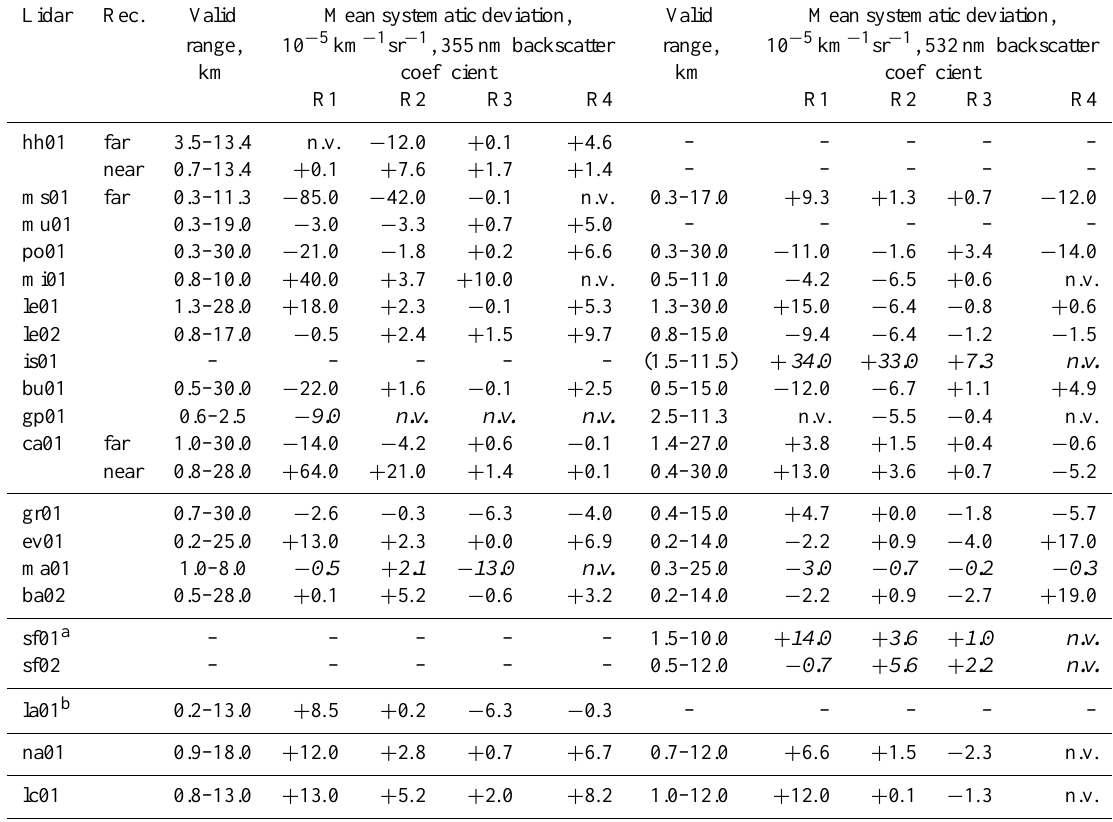
Table 6. Valid range and mean systematic deviation of backscatter coefficients at 355 and 532nm in four height ranges: R1 (lowest valid range–2.5km), R2 (2.5–6km), R3 (6–12km), and R4 (12km–highest valid range). Italicized numbers indicate Fernald retrievals; all other numbers belong to the Raman method. n.v. denotes not valid. Rec. denotes receiver range.